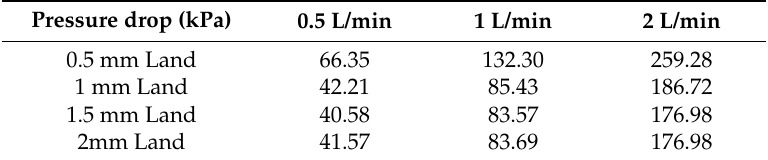
Table 1. Average pressure drop at different inlet flow rates for four different serpentine flow fields at the cathode side.